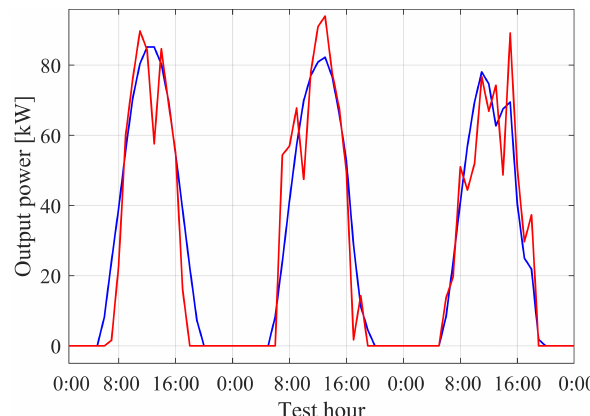
Figure 3. Predicted (red) and real (blue) value of output power in the mid of June 2018 by using the 2D-CNN approach with the univariate input on 3-day test set (see Table 5, row 1, column 2).